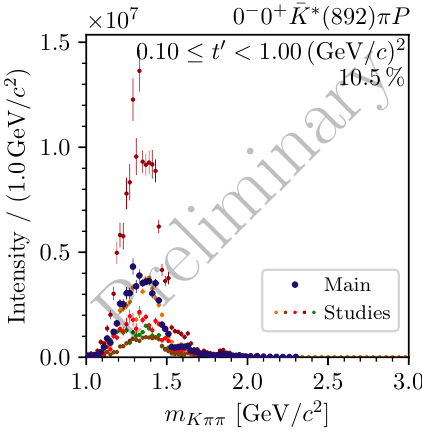
Figure 5: Intensity distribution of the 0 − 0 + K ∗ (892) π P wave in the range 0 . 1 ≤ t (cid:48) < 1 . 0 (GeV / c ) 2 . The large blue data points represent the result of the “main” analysis. The small data points show the results from five systematic studies, where di ff erent aspects of the analysis where changed. Each systematic study is shown by one color. The percentage num- ber in the upper-right corner of the intensity spectrum is the relative intensity of this wave as obtained in the “main”